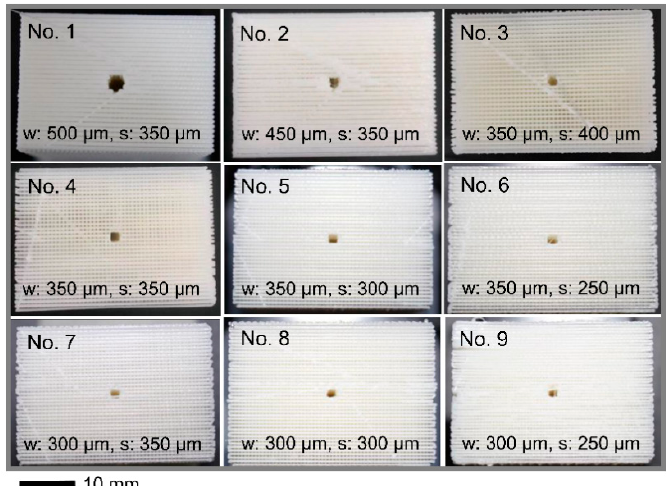
Figure 7. Nine specimens of 3D printed grid structures of PLA with a variety of feature dimensions in computer-aided design, where the line width (w) and spacing (s) are combined within a range of 250 μ m to 500 μ m.